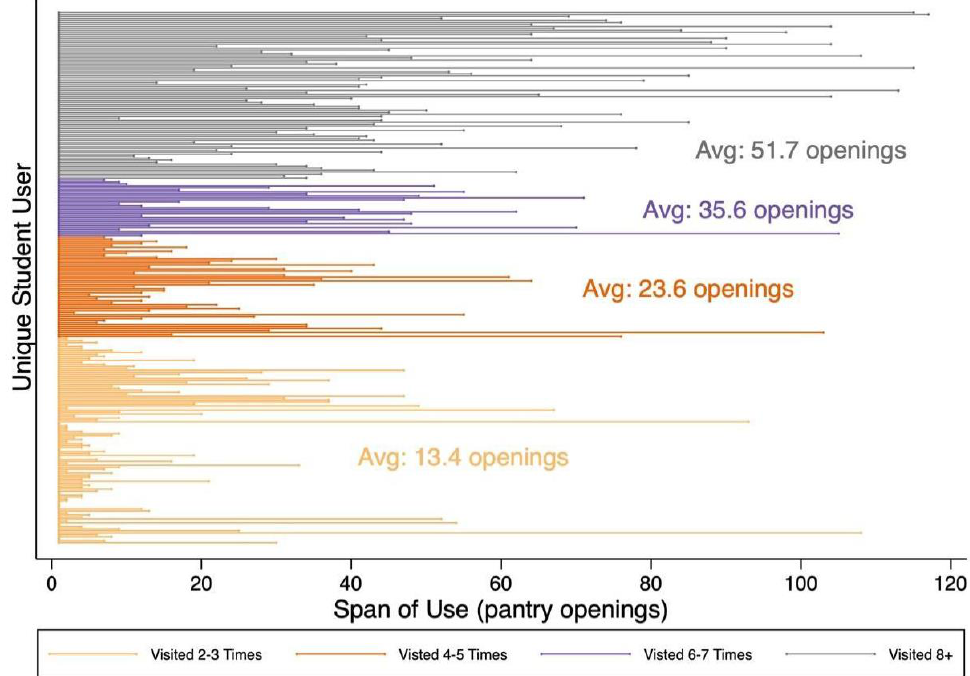
Figure 3. The span of use per student user with students grouped by the number of visits and the span is measured as the number of pantry openings between a student’s first and last visit. The average span of use is reported per group.